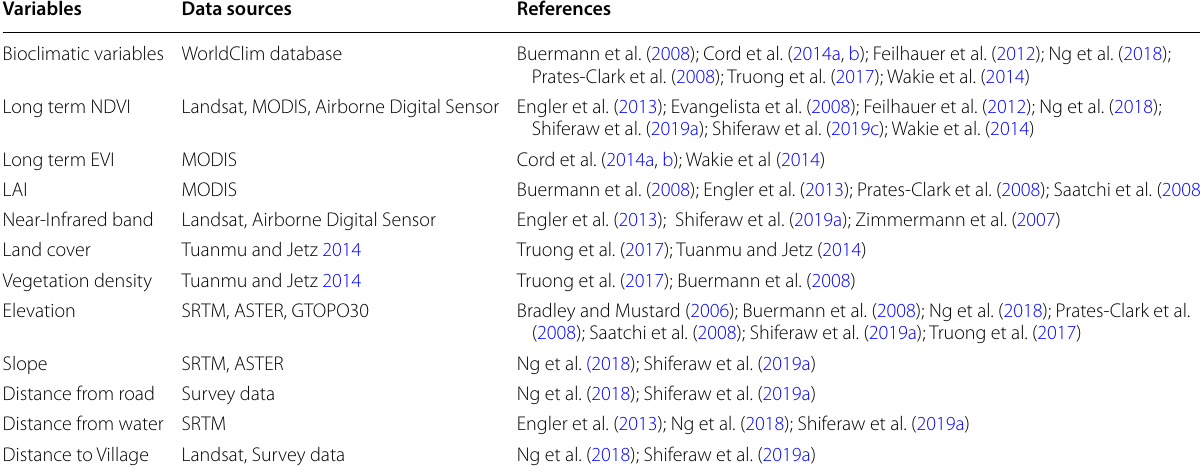
Table 3 Variables and their data sources used for integrating (bio) climatic and remote sensing data